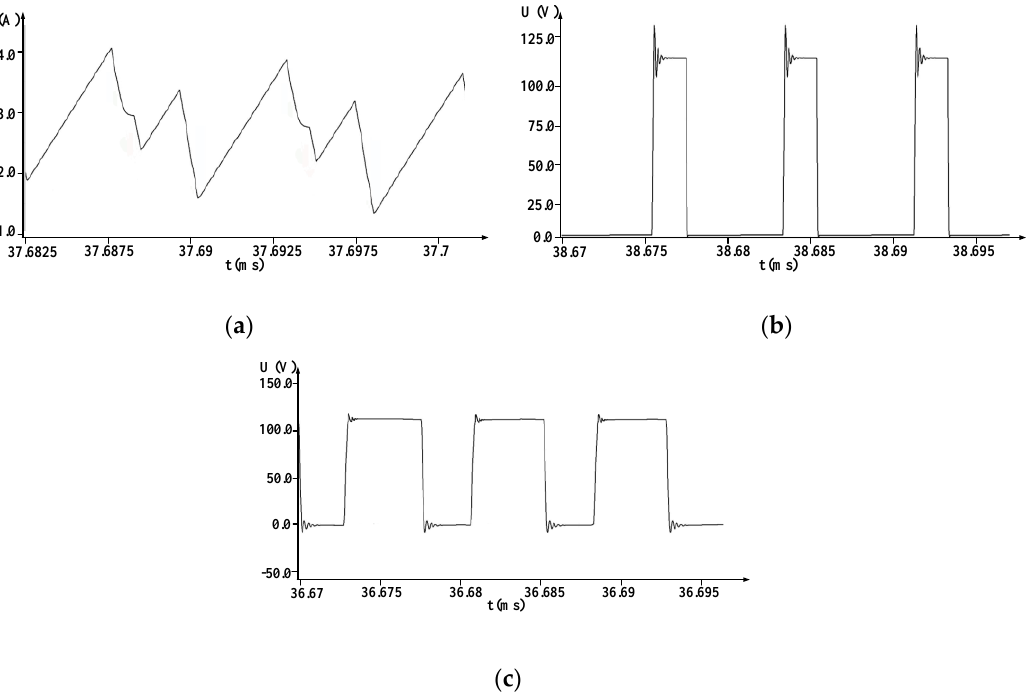
Figure 13. Circuit waveforms obtained through Saber simulation. ( a ) Simulation waveform of inductor current. ( b ) Simulation waveform of MOSFET (metal-oxide-semiconductor field-e ff ect transistor) voltage. ( c ) Simulation waveform of diode